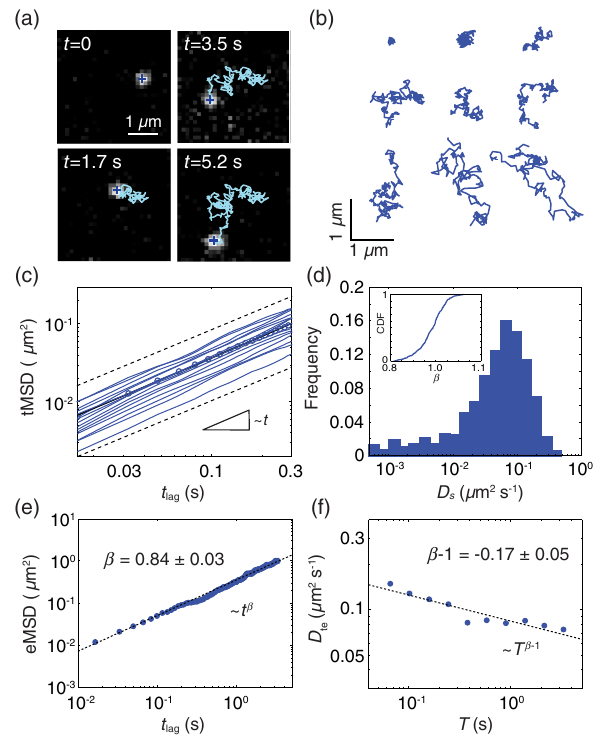
FIG. 1. DC-SIGN diffusion shows weak ergodicity breaking and aging. (a) Representative video frames of a quantum-dot- labeled WT DC-SIGN molecule diffusing on the dorsal mem- brane of a CHO cell. The centroid position of the bright spot ( þ ), corresponding to a single quantum dot, is tracked and recon- nected to build up the DC-SIGN trajectory, shown by the cyan line. (b) Representative trajectories for the same recording time (3.2s). (c) Log-log plot of the time-averaged MSD for individual trajectories (blue lines). The dashed lines scale linearly in time, showing that tMSD is compatible with pure Brownian motion ( β ¼ 1 ). The symbols (circle) correspond to the average tMSD. A linear fit to the log-log transformed data (black line) provides β ¼ 0 . 95 (cid:3) 0 . 05 . (d) Distribution of short-time diffusion coef- ficients as obtained from linear fitting of the time-averaged MSD for all the trajectories. Inset: Cumulative distribution function (CDF) of the exponent β obtained from nonlinear fitting of the tMSD of all the trajectories. (e) Log-log plot of the ensemble- averaged MSD. A power-law fit of the data (dashed line) provides an exponent β ¼ 0 . 84 , showing subdiffusion. (f) Log-log plot of the time-ensemble-averaged diffusion coefficient as a function of the observation time T . The diffusion coefficients are obtained by linear fitting of the time-ensemble-averaged MSD. A power- law fit (dashed line) provides an exponent β − 1 ¼ − 0 . 17 , revealing aging and in good agreement with the value of β found in